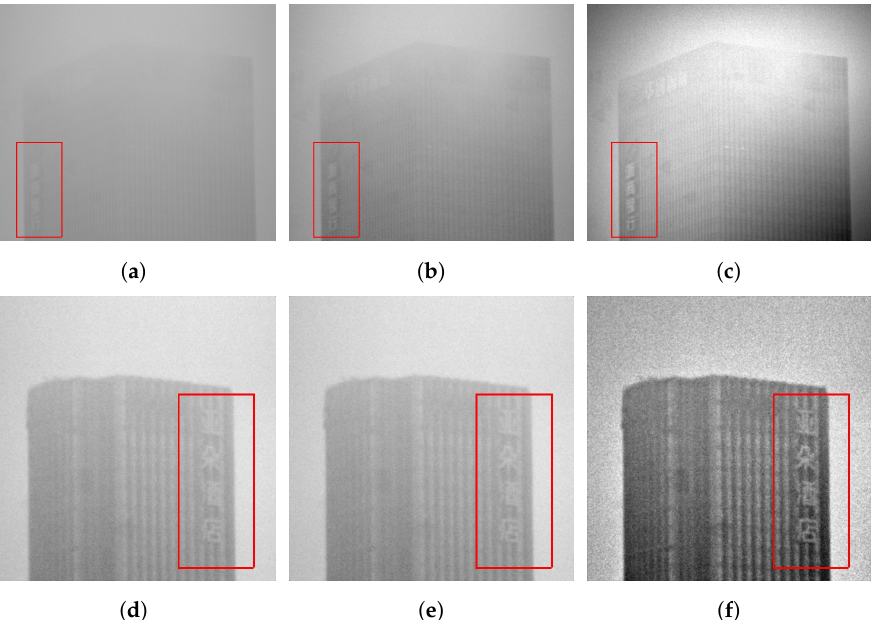
Figure 8. Comparisons between the original images and the dehazed images in heavy hazy back- ground. ( a , d ) are the original images; ( b , e ) are the images dehazed by Schechner’s method; ( c , f ) are the images dehazed by our method.